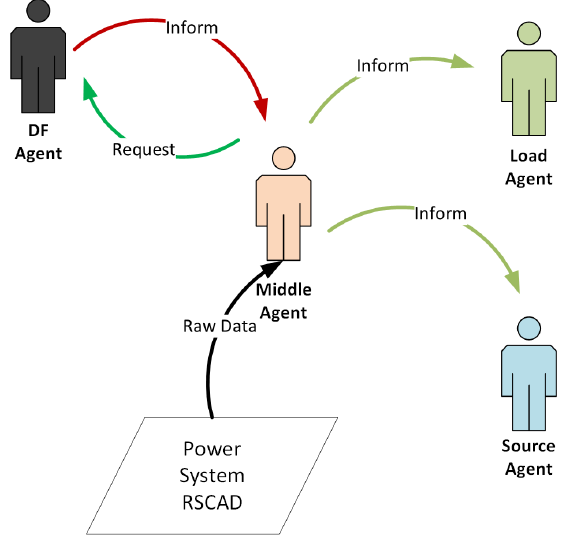
Figure 6. Data Exchange in